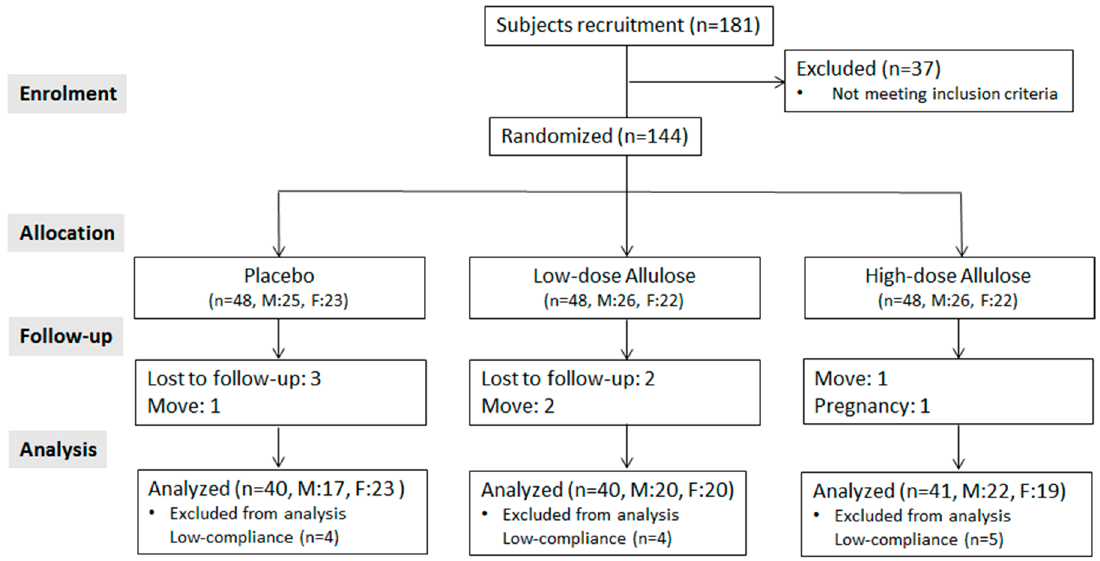
Figure 1. Study flow of the preliminary study for evaluating the dose-dependent effect of D -allulose. M, Males; F, Females